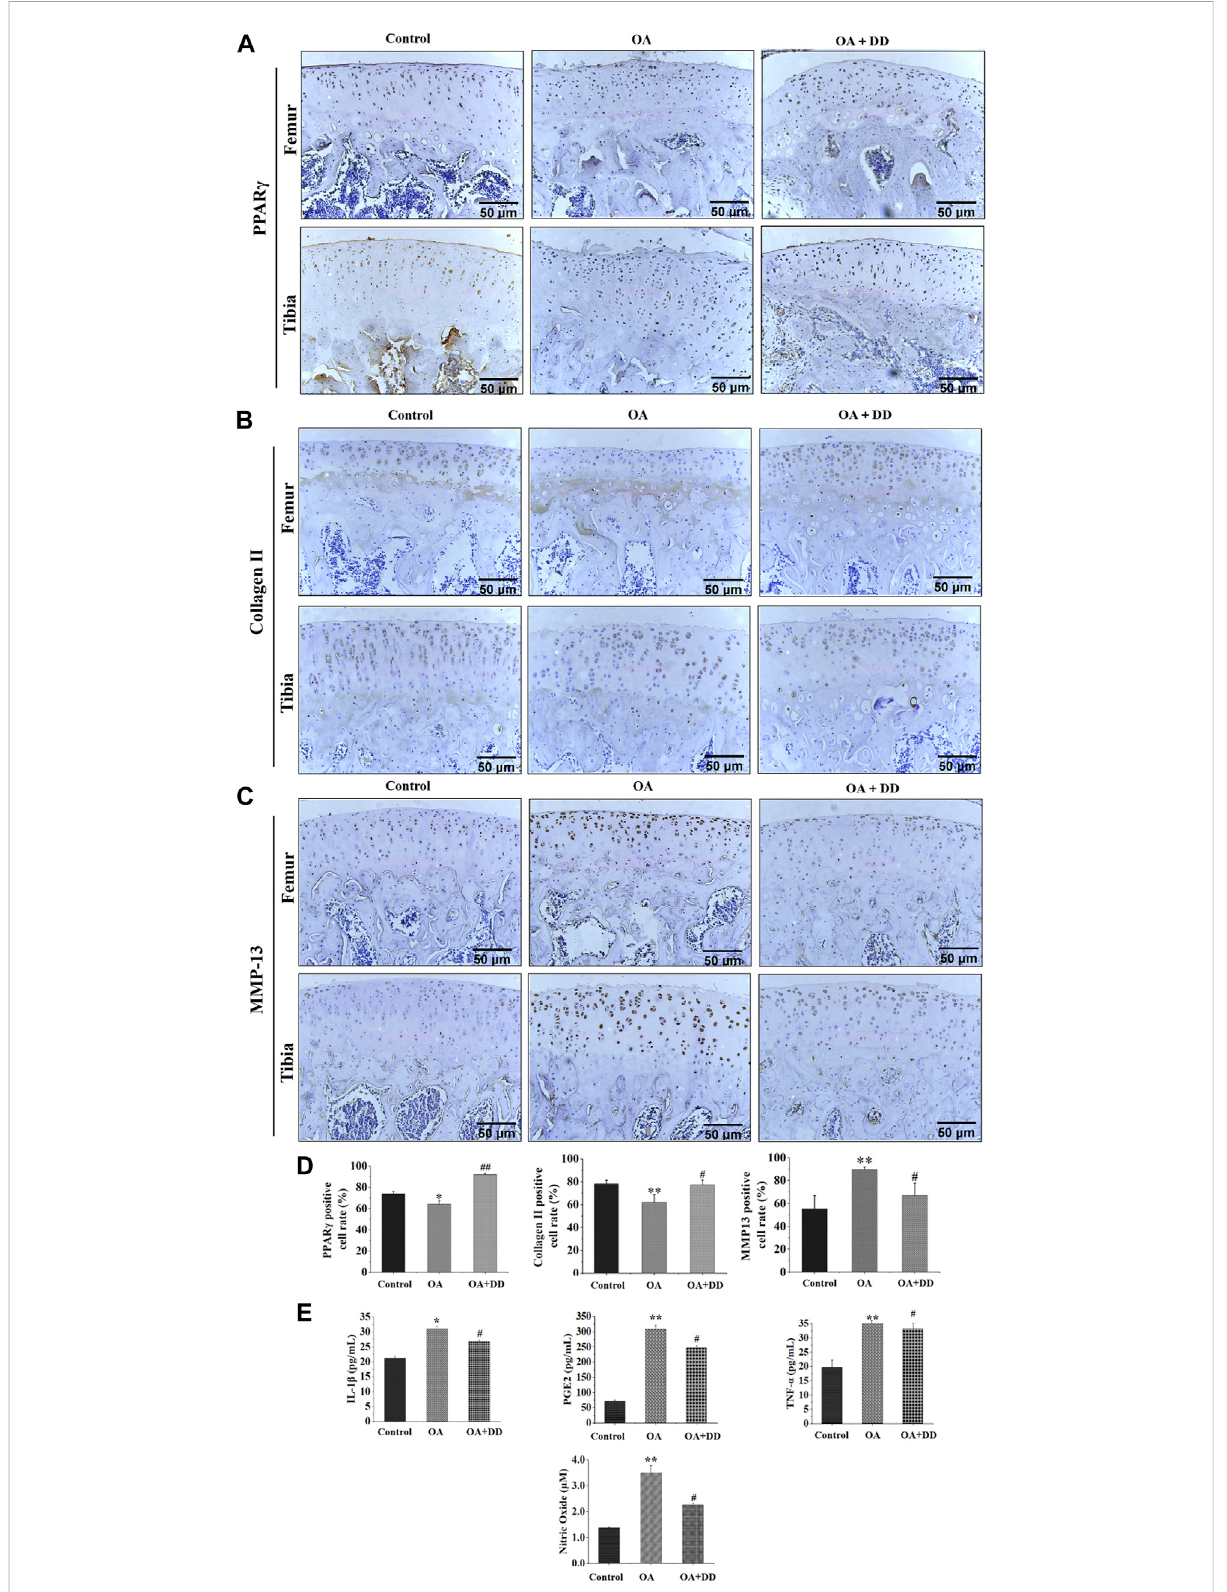
FIGURE 2 DD reduced cartilage ECM degradation and inhibited in fl ammatory factor production in OA rats. (A) The expression of PPAR γ in sections of cartilage; (B) The expression of Collage II in sections of cartilage; (C) The expression of MMP-13 in sections of cartilage; (D) Quanti fi cation of histology positive cells ofPPAR γ , Collage II, and MMP-13; (E) The effect of DD on IL-1 β , PGE2, TNF- α , and NO in fl ammatorycytokines.The data are presentedas mean ± SD ( n = 3). * p < 0.05, ** p < 0.01 compared with the control group; # p < 0.05, ## p < 0.01 compared with the OA